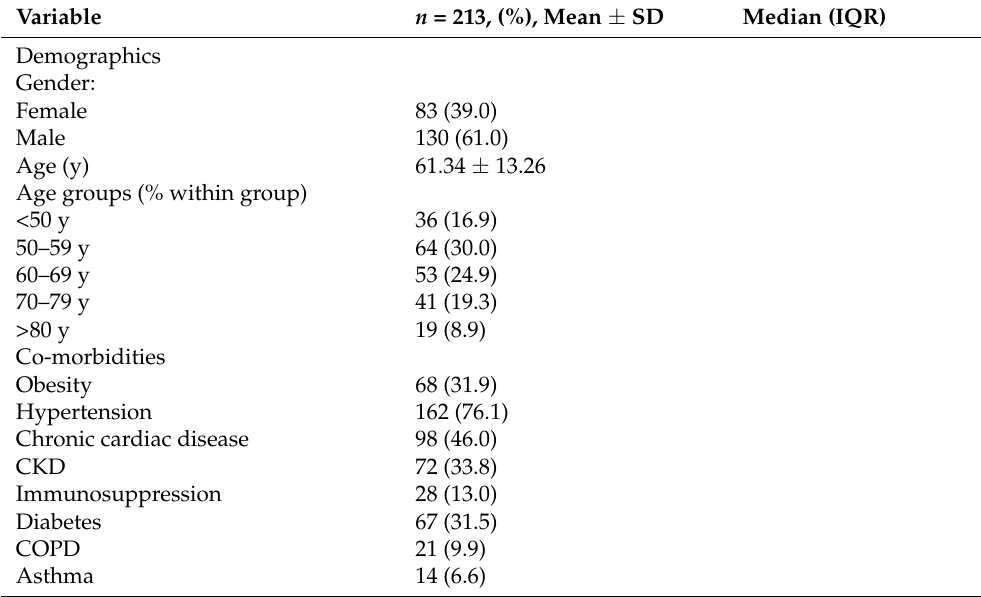
Table 2. Baseline characteristics of the